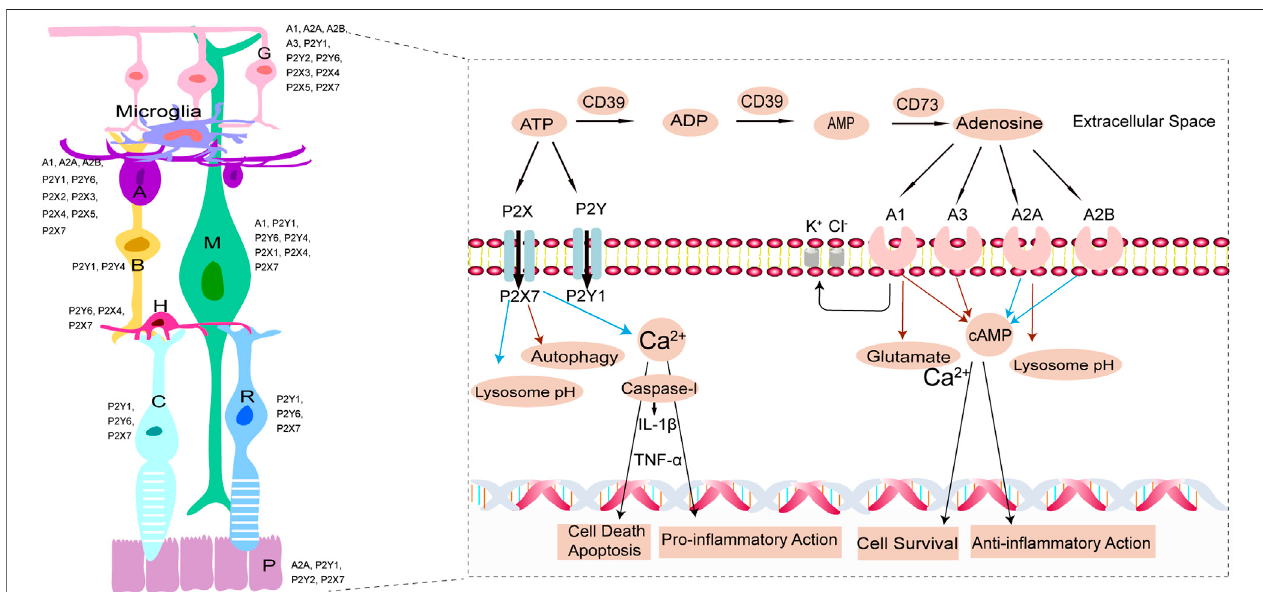
FIGURE 1 | In the left, schematic representation illustrating the expression of P2 and P1 receptors (Ventura et al., 2019). P , Pigment epithelium cell; R, rod cell; C, conecell;H,horizontalcell;B,bipolarcell;M,Müllercell;A,amacrinecell;G,ganglioncell.Intheright,ATPandadenosinemetabolizingintheextracellularconditionsand mediate pathologic process within the retina. Extracellular ATP is hydrolyzed to ADP, AMP, adenosine by the activity of CD39 and CD73. Extracellular ATP and adenosine interact, therefore causing their activation, with P2 (P2X, P2Y) and P1 (A1, A2A, A2B, A3) purinergic receptors, respectively. On one hand, Calcium- dependent cell death pathways due to increased ATP or glutamate and in fl ammasome-dependent cell death pathway induced by P2X7 pore formation accompanied withactivationofapoptosis-inducingfactor, both contribute toretinal cells death or apoptosis. Extracellular ATPstimulates retinal microglia activity torelease neurotoxic factors,(e.g.TNF- α ,IL-1 β )exertingpro-in fl ammatoryaction.StimulationofP2X7RraiseslysosomalpH(bluearrows)inRPEcellsandlowersautophagy,whichcontribute to lysosomal alkalinization and lipofuscin accumulation. On the other hand, A1R and A3R inhibit adenylyl cyclase decreasing intracellular cyclic adenosine monophosphate (cAMP) levels (red arrows) while A2AR and A2BR activate adenylyl cyclase increasing intracellular cAMP levels (blue arrows). Adenosine acting at A1R signi fi cantly decreases the glutamate-induced calcium in fl ux (red arrows) contributing to cell survival. Adenosine exerts anti-in fl ammatory action, as well as decreases lysosomepH(redarrows).Moreover,A1Ropeningthepotassiumandchloridechannels,increasesthe fl uidclearancefromtheedematousretinaviaincreasedextrusion into the blood of ionic